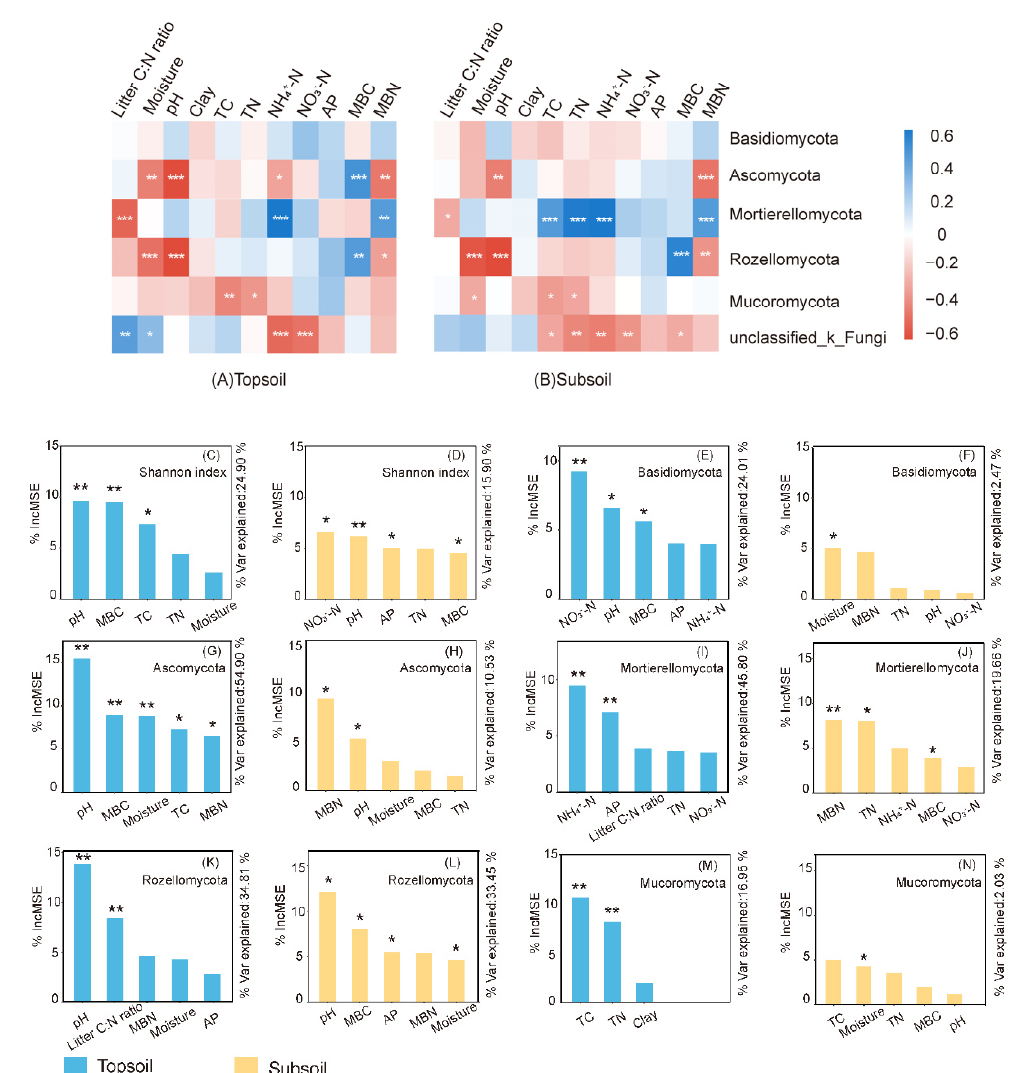
Figure 6. Environmental predictors of the fungal diversity and dominant phyla in different forest types based on Random Forest analysis and Correlation analysis. ( A , C , E , G , I , K , M ) topsoil; ( B , D , F , H , J , L , N ) subsoil. *** p < 0.001; ** p < 0.01; * p < 0.05.